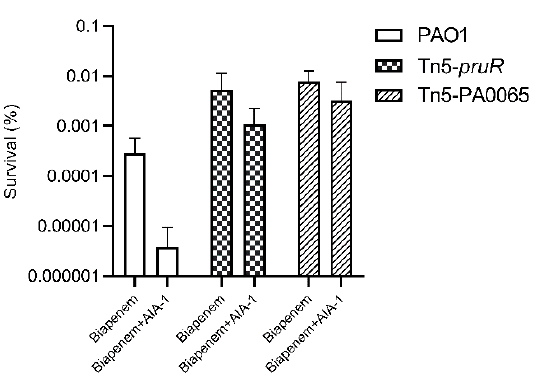
Figure 1. The survival rate of PAO1, Tn5- pruR, and Tn5-PA0065 in a killing assay using biapenem (32 mg/L) and a combination of biapenem and autoinducer analog-1 (AIA-1) (32 mg/L). Error bars show SD for three independent experiments.